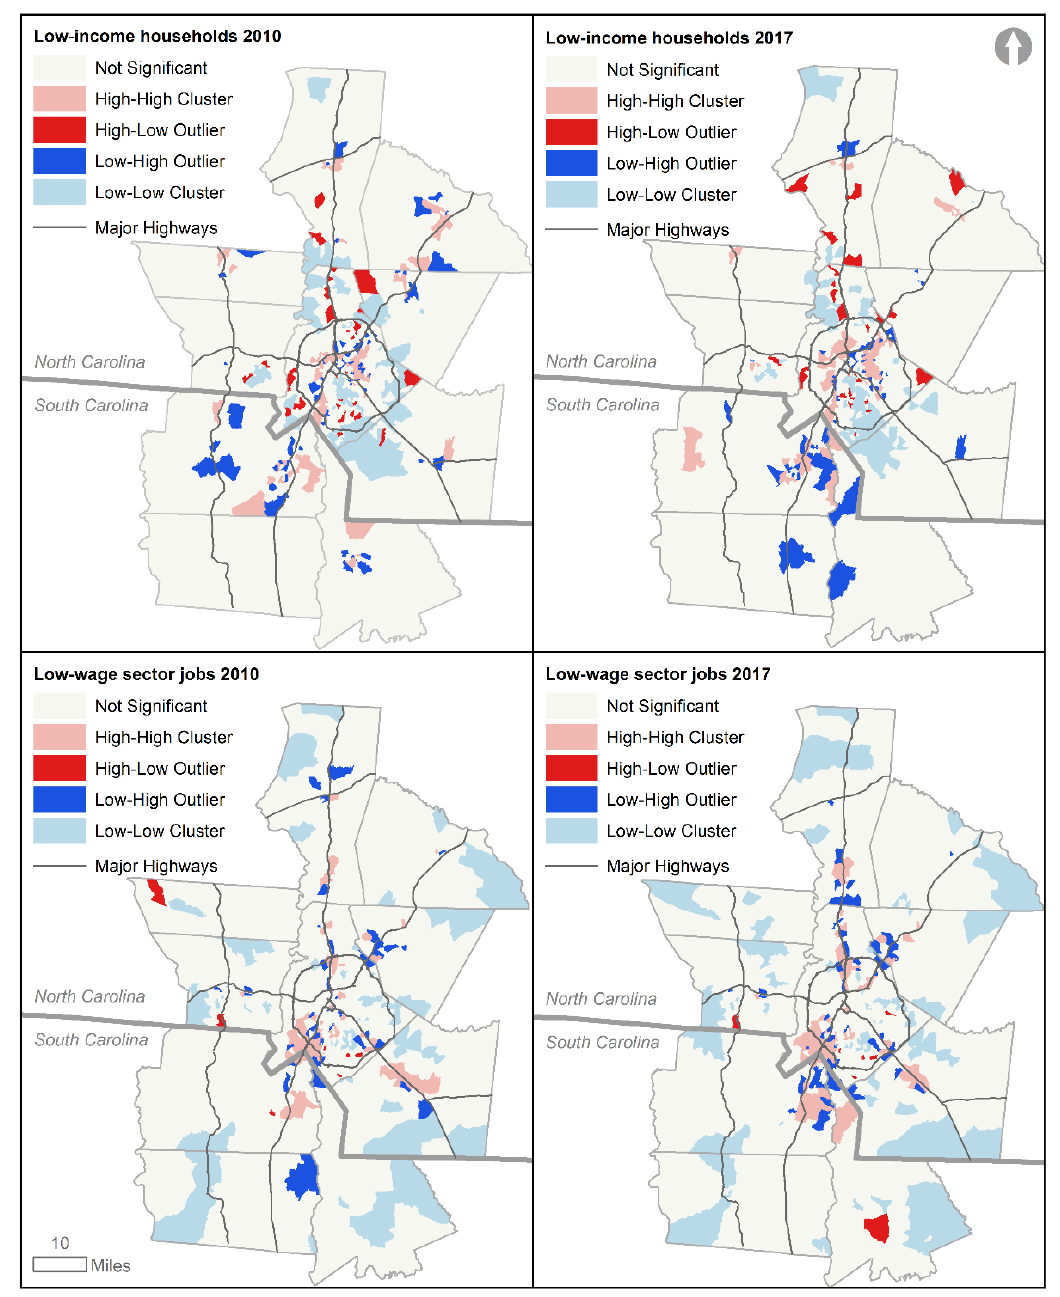
Figure 2. Local Moran’s I clusters of low-income households and lower-wage jobs in 2010 and 2017,